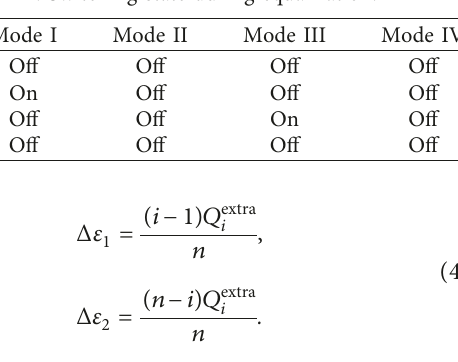
Table 2: Switching state during